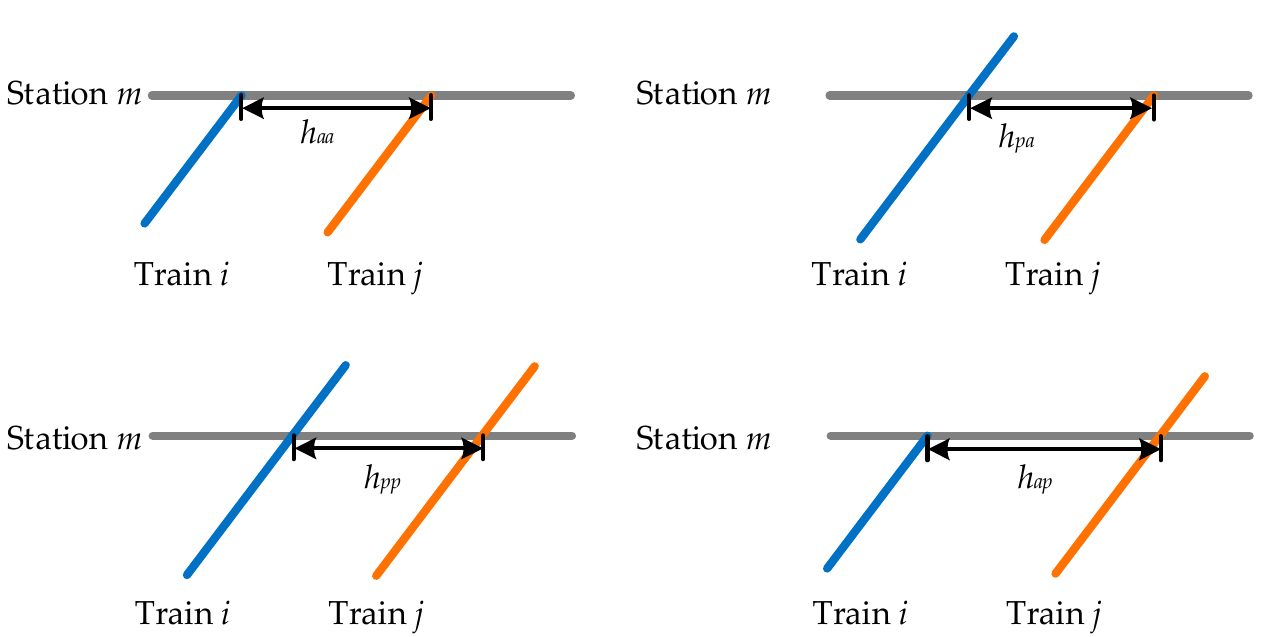
Figure 3. Departure headway in different situations of train stops.